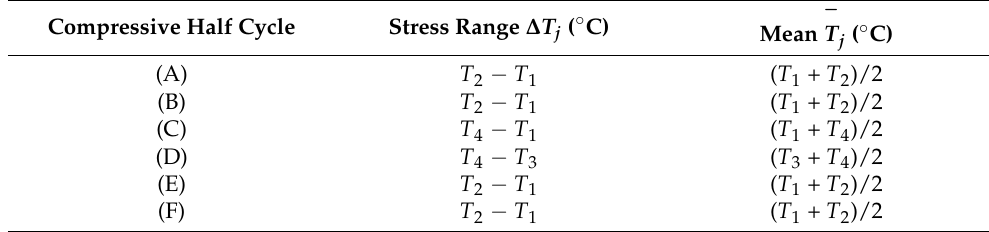
Table 7. Half-cycle counting for compressive valleys.